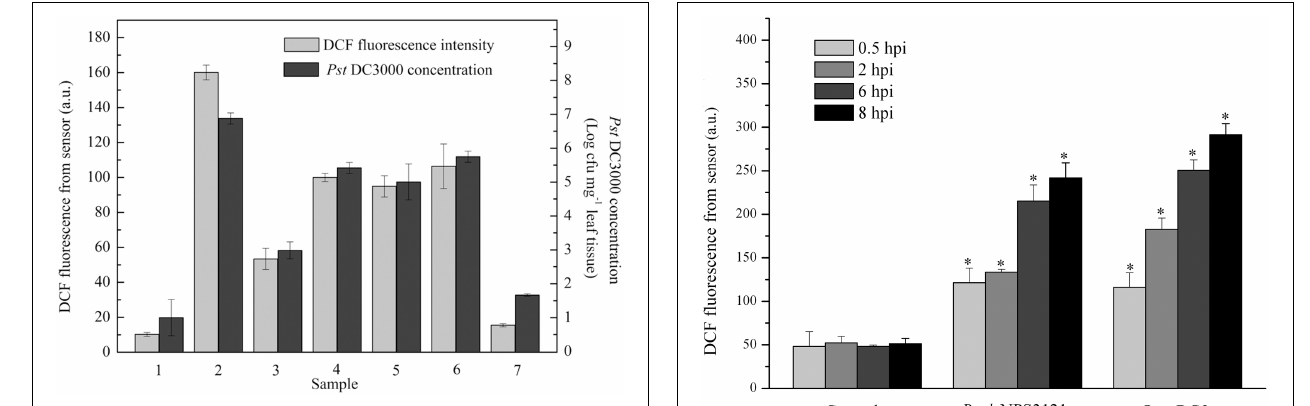
FIGURE 5 | Quantitative analysis of time-dependent changes in the dichlorofluorescein (DCF) fluorescence in A. thaliana leaves infected by 10 3 cfu ml − 1 Pseudomonas syringae pv. phaseolicola NPS3121 ( Psph NPS3121) ( Psph NPS3121) and 10 2 cfu ml − 1 Pseudomonas syringae pv. maculicola DG3 ( Psm DG3) in 10mM MgCl 2 . The mean ± SD of the fluorescence intensity is shown for five independent A. thaliana leaves inoculated with various pathogens or 10mM MgCl 2 (Control). There were a significant effect of DCF fluorescence obtained from optical device on the type of infected plant pathogen at 0.5 hpi ( F 1 , 2 = 108 . 413, p < 0 . 01), that at 2 hpi ( F 1 , 2 = 979 . 962, p < 0 . 01), that at 6 hpi ( F 1 , 2 = 1125 . 01, p < 0 . 01), that at 8 hpi ( F 1 , 2 = 263 . 57, p < 0 . 01). Asterisks ( ∗ ) indicate